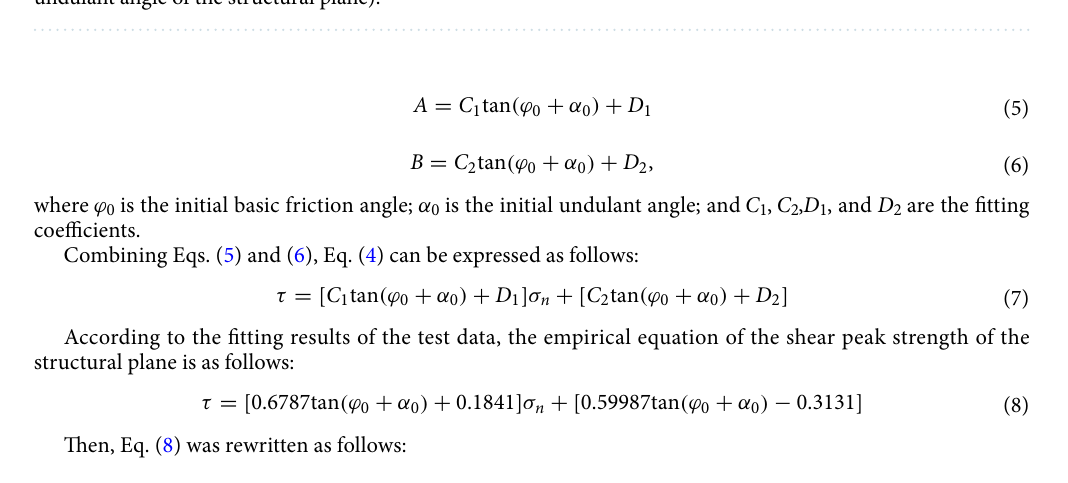
Figure 7. Shear stress–displacement curves of three structural planes under different normal stresses ( α is the undulant angle of the structural